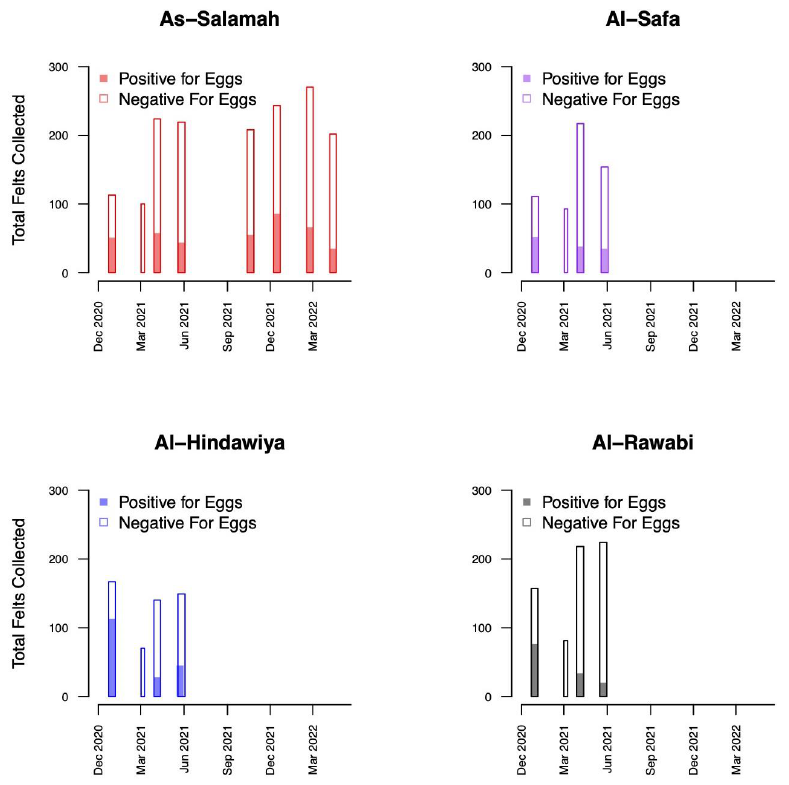
Figure 3. Bar plots showing the temporal distribution of felt collections over the four districts (As- Salamah, Al-Safa, Al-Hindawiya, and Al-Rawabi) in Jeddah, Saudi Arabia. Bar widths correspond to the intervals (either one or two weeks) over which felt collections were performed. Colored and non-colored proportions of bars show the proportions of collected felts that were positive and negative for egg presence, respectively.